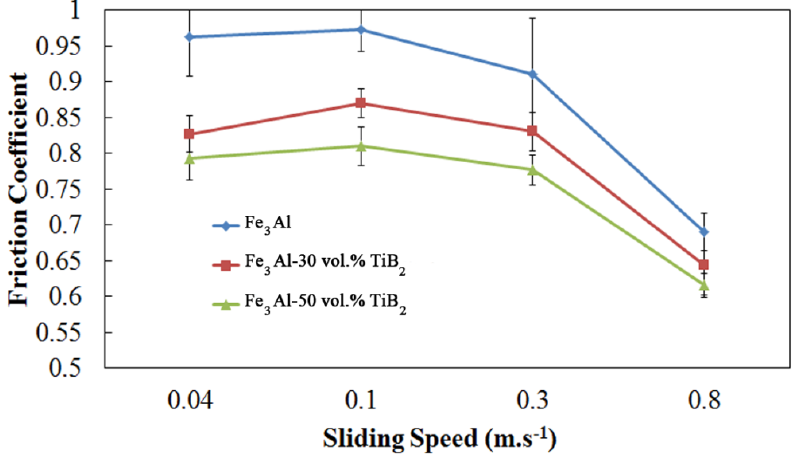
Figure 8. Friction coefficient versus sliding speed at the applied load of 5 N.